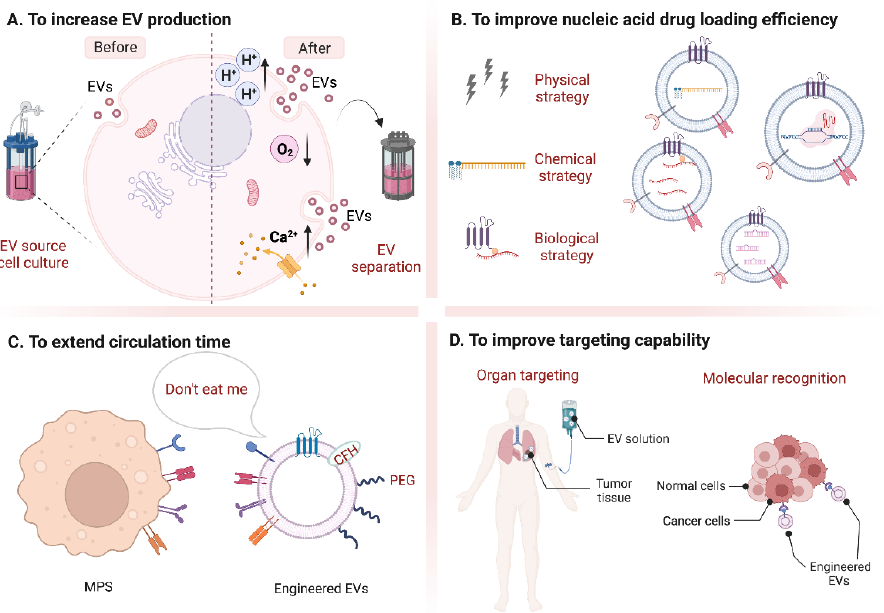
Figure 1. Summary of different modification strategies for EVs. ( A ) to increase EV production; ( B ) to improve nucleic acid drug loading efficiency; ( C ) to extend circulation time; ( D ) to improve targeting capability. (Created with BioRender.com, accessed on 23 August